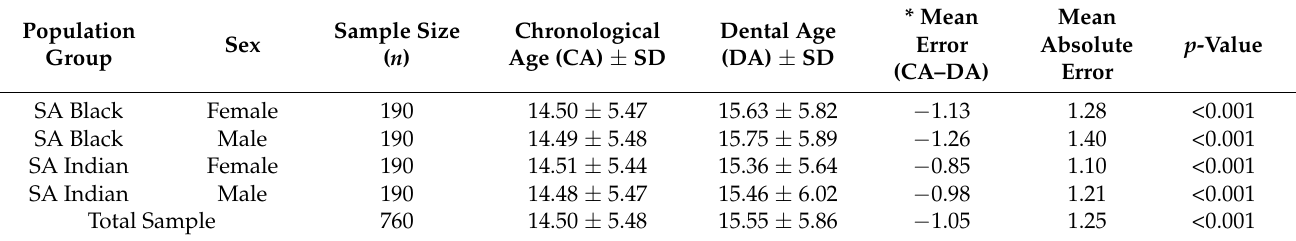
Table 1. Dental age estimation using the London Atlas in the select KwaZulu-Natal sample (in